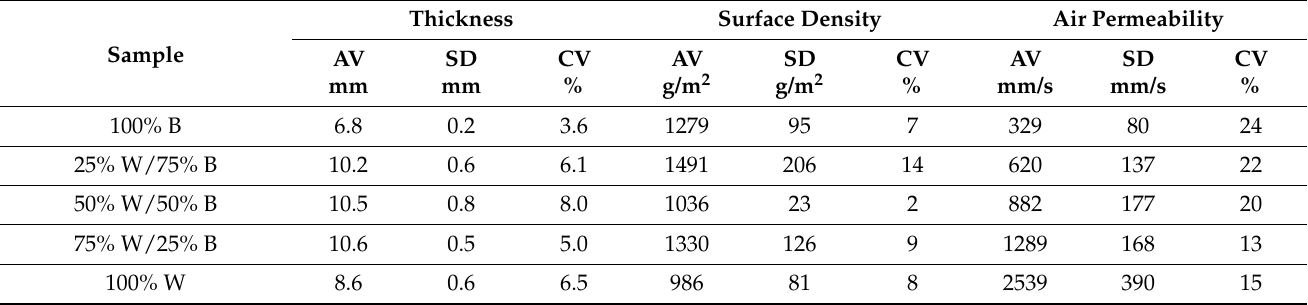
Table 1. Basic parameters of mats produced from mountain sheep wool and flax and hemp